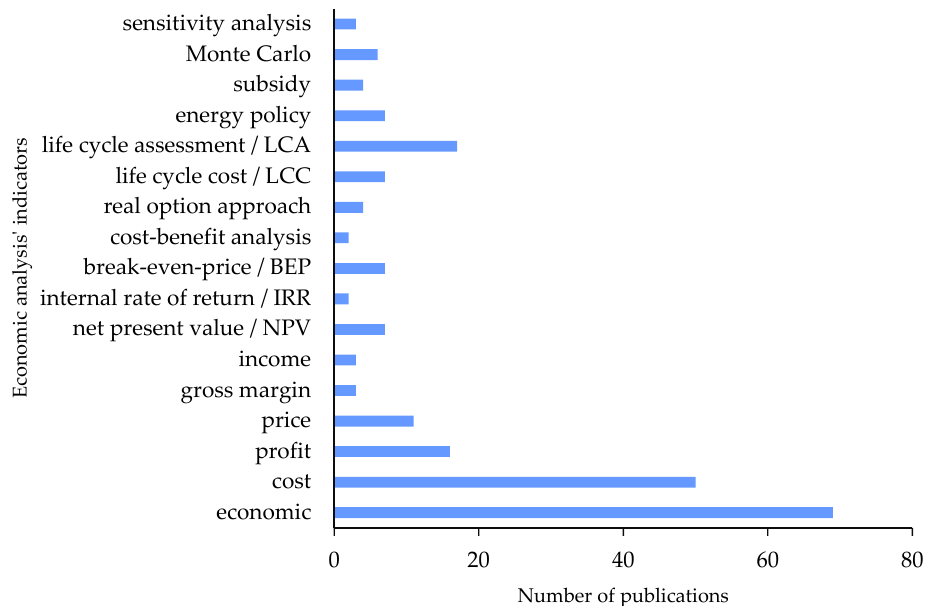
Figure 7. Frequency of incidence among particular indicators of economic analysis in the selected papers.